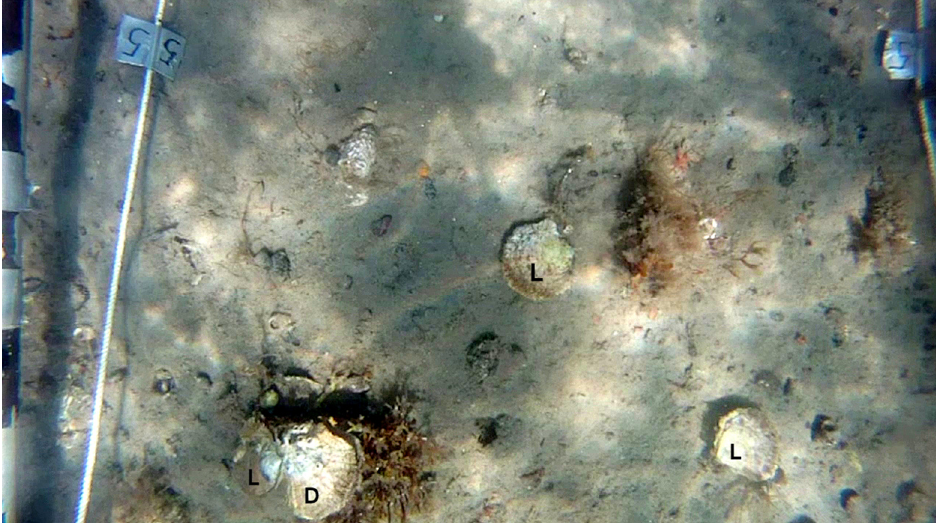
Fig 3. Still frame from the video recording. Still frame showingthe field of view from the video camera including three living (L) and one dead (D) oyster and the transect borders.